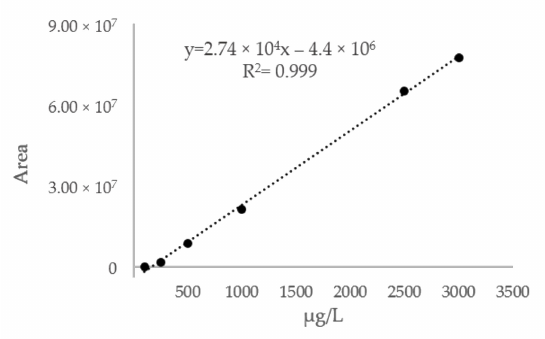
Figure 1. Calibration curve in breast milk sample processed with immunoa ffi nity purification. LLOQ and LOD were 100 and 27 ng mL − 1